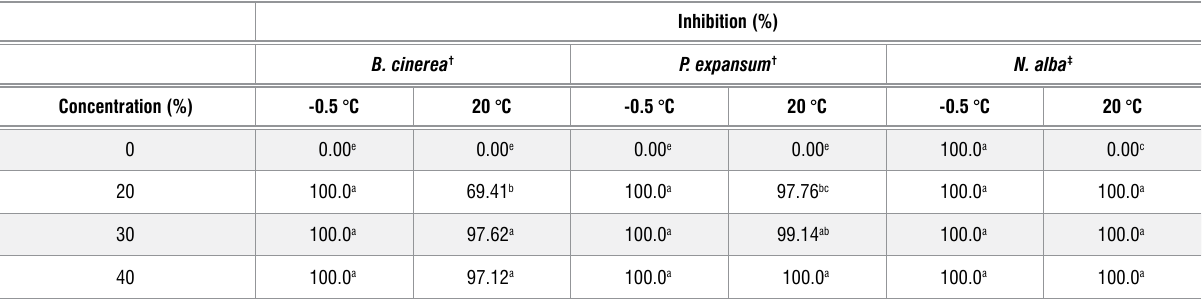
Table 5: Inhibitory volatile action of aqueous diluted garlic extracts against mycelial growth of Botrytis cinerea , Penicillium expansum and Neofabraea alba , incubated at -0.5 °C with further incubation at 20 °C